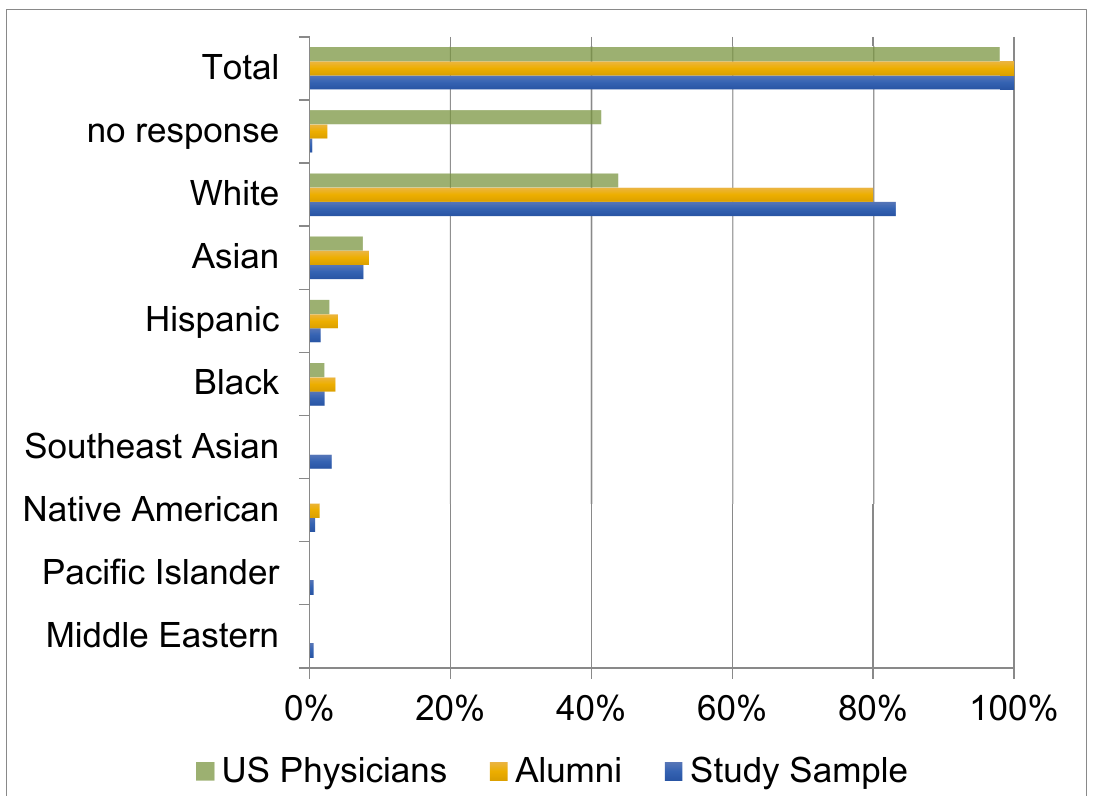
Figure 1. Racial identification of (N = 509) participants and all U.S. doctors.